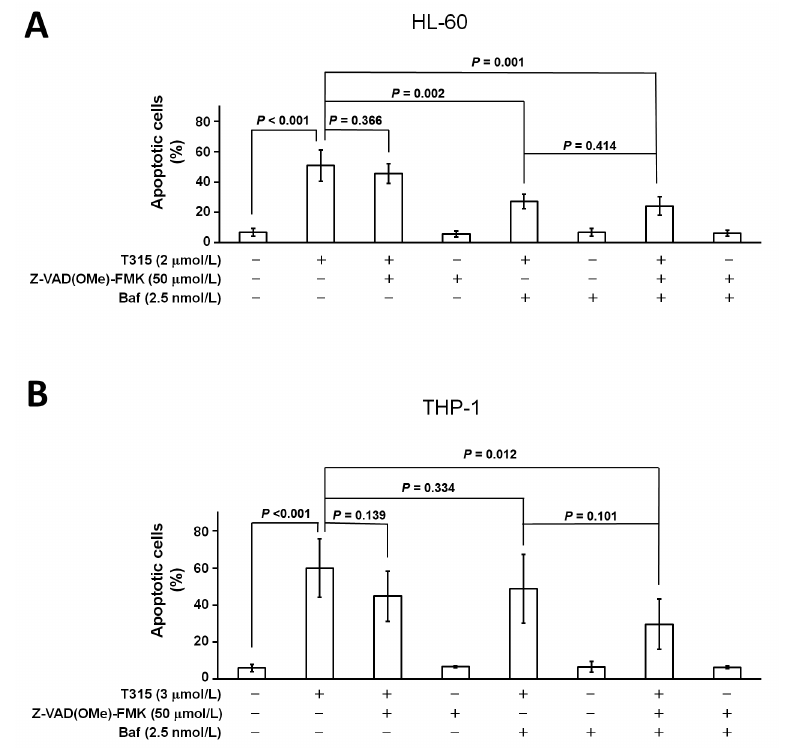
Figure 5. T315-mediated cytotoxicity is rescued by combination of an apoptosis inhibitor and an autophagy inhibitor. Cells were treated with DMSO vehicle or T315 for 24 h with or without pretreatment of Z-VAD(OMe)-FMK and/or bafilomycin-A1 (Baf) for 1 h, and then analyzed by a flow cytometer. ( A ) For HL-60 cells ( n = 5); ( B ) For THP-1 cells ( n = 5).